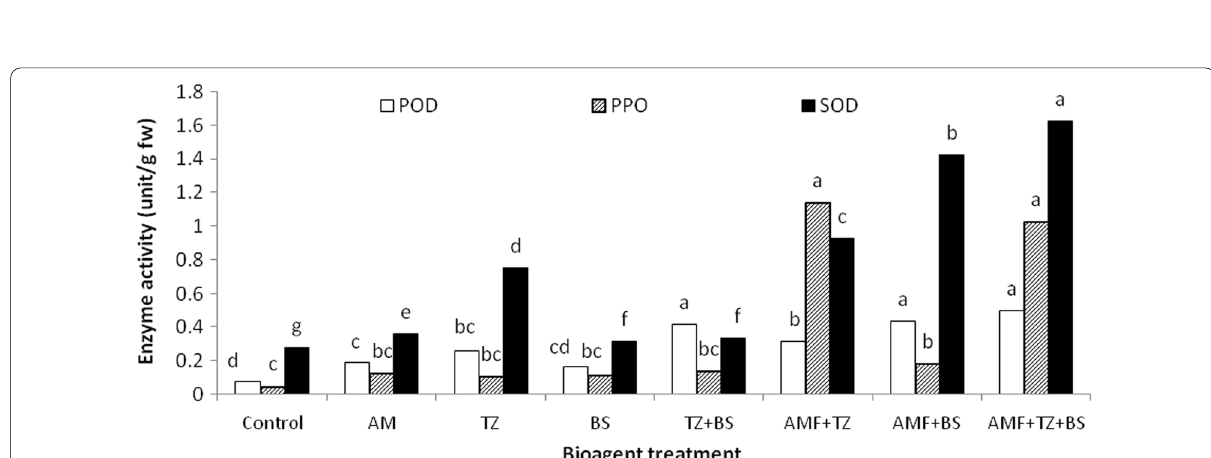
Fig. 3 Effect of AMF and PGPRs on peroxidase, polyphenol‑oxidase and superoxide dismutase activity in squash plant. Bars with different letters are significantly different (LSD, P > 0.05). Arbuscular Mycorrhizal fungi (AMF), Trichoderma harzianum ( TZ ) , Bacillus subtills (BS), control (without treatment), (SOD), superoxide dismutase, (POD), peroxidase, (PPO),